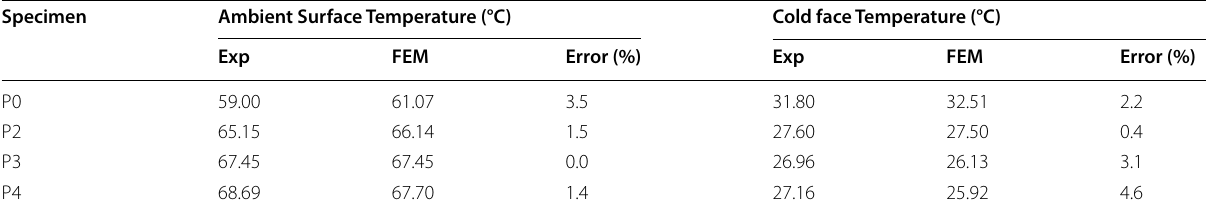
Exp experimental, FEM finite element model